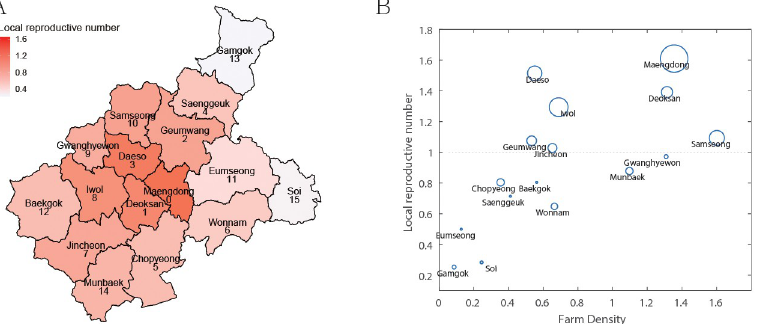
Fig 4. (A) Local reproductive numbers in each town. The darker red color represents the larger reproductive number. (B) Local reproductive number with respect to farm density in each town. The size of circle shows the size of duck farms. Reprinted from [27] under a CC BY license, with permission from National Geographic Information Institute, original copyright 2017.